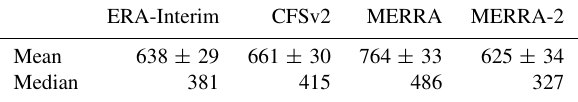
Table 3. Statistics of the trajectory separations after 5 days in kilo- metres. Corresponding separations over time plots are provided in Fig. 5. The errors on the means are the 90% confidence